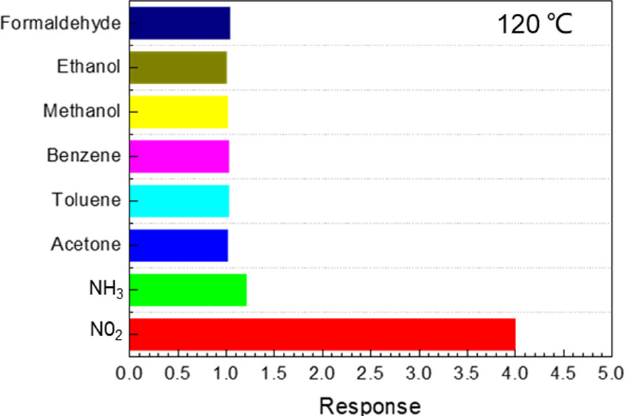
Figure 11. The selectivity of the Au/SnS 2 -0.5-based sensor to 4 ppm NO 2 and several possible interfering gas species.